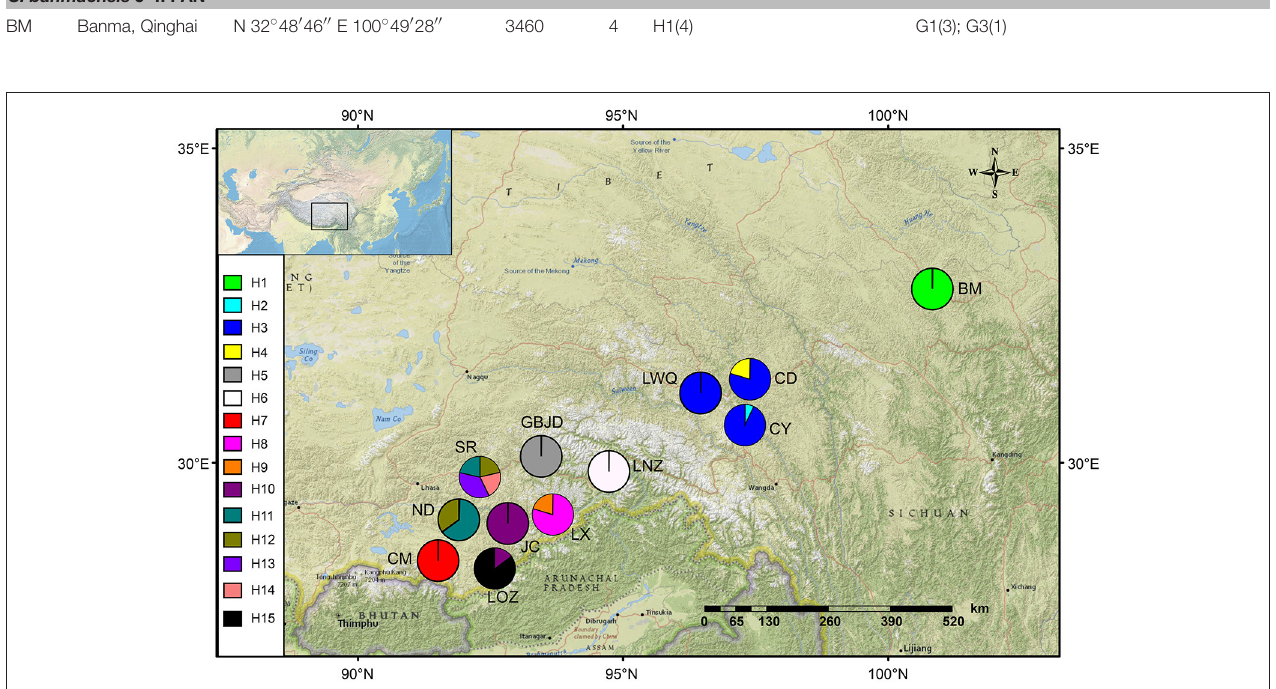
FIGURE 2 | Geographical distribution of sampled populations of Saxifraga umbellulata (CM, LX, JC, ND, SR, LOZ), S. pasumensis (CY, CD, GBJD, LWQ, LNZ) and S. banmaensis (BM). The frequencies of cpDNA haplotypes within each population are shown in the pie